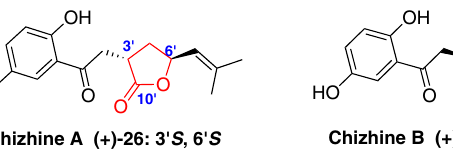
Fig. 3 Structures of GMs with a (6 0 ? 10 0 )- or (7 0 ? 10 0